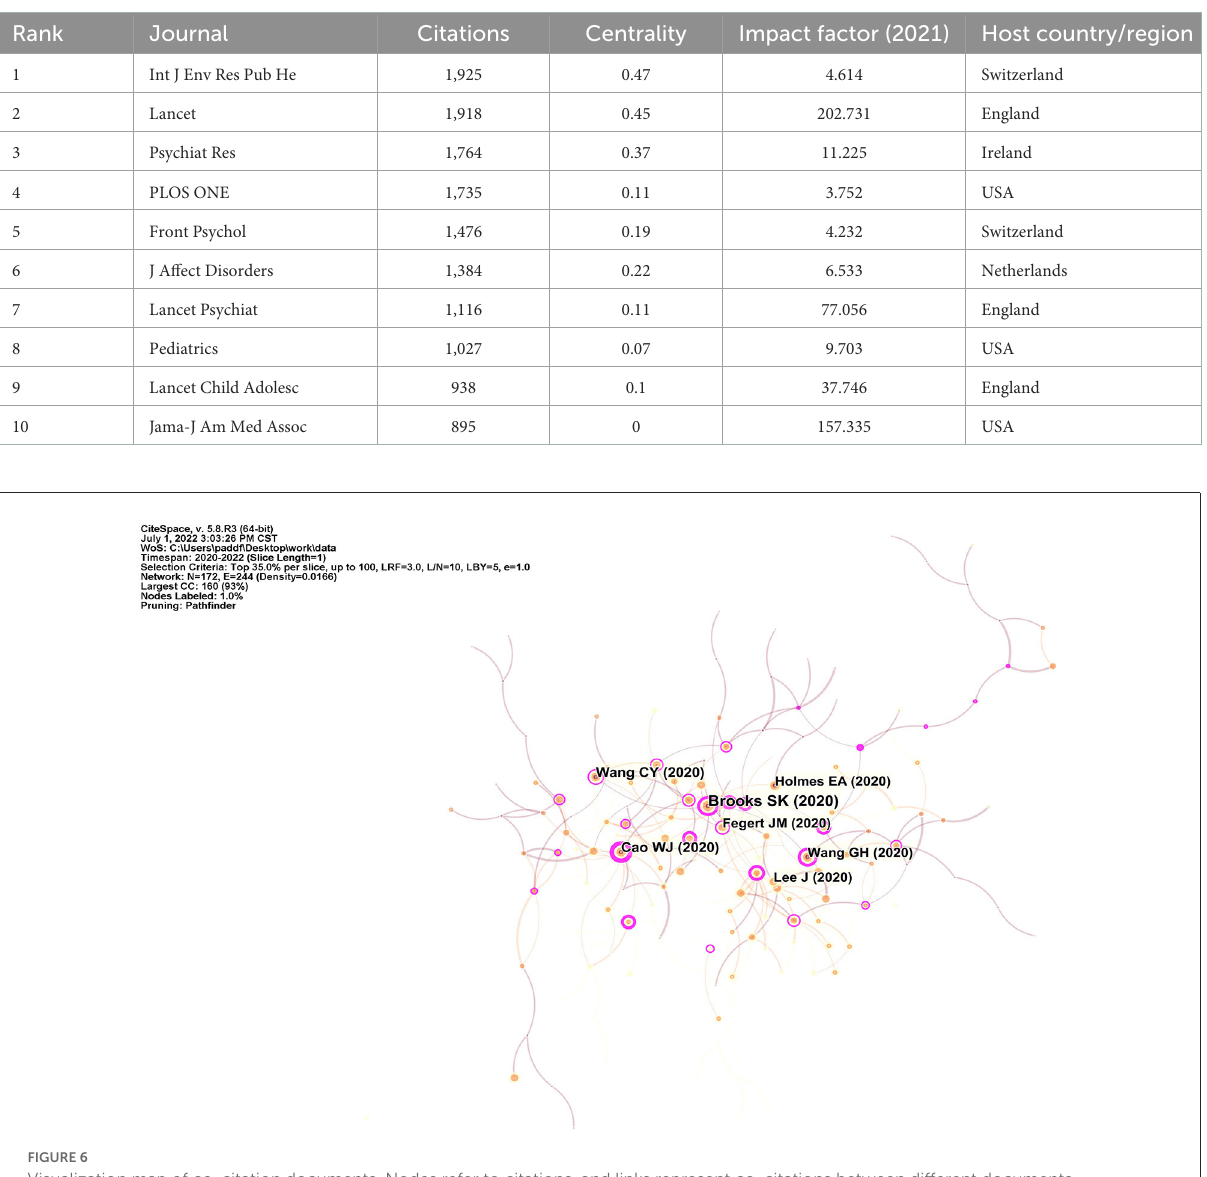
TABLE 4 Top 10 highly cited journals.